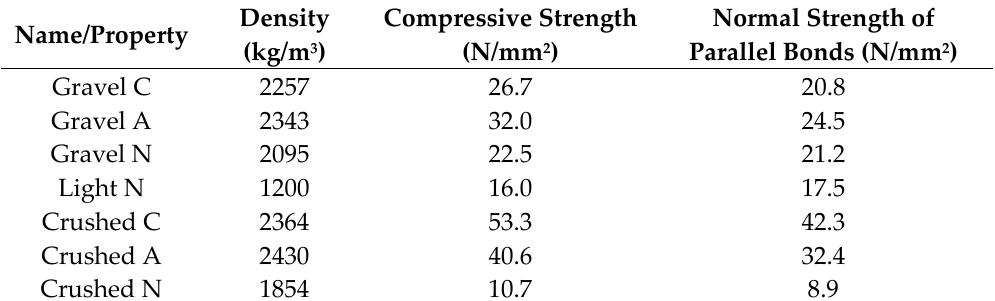
Table 2. Experimental (density and compressive strength) and numerical (Normal strength of parallel bonds)